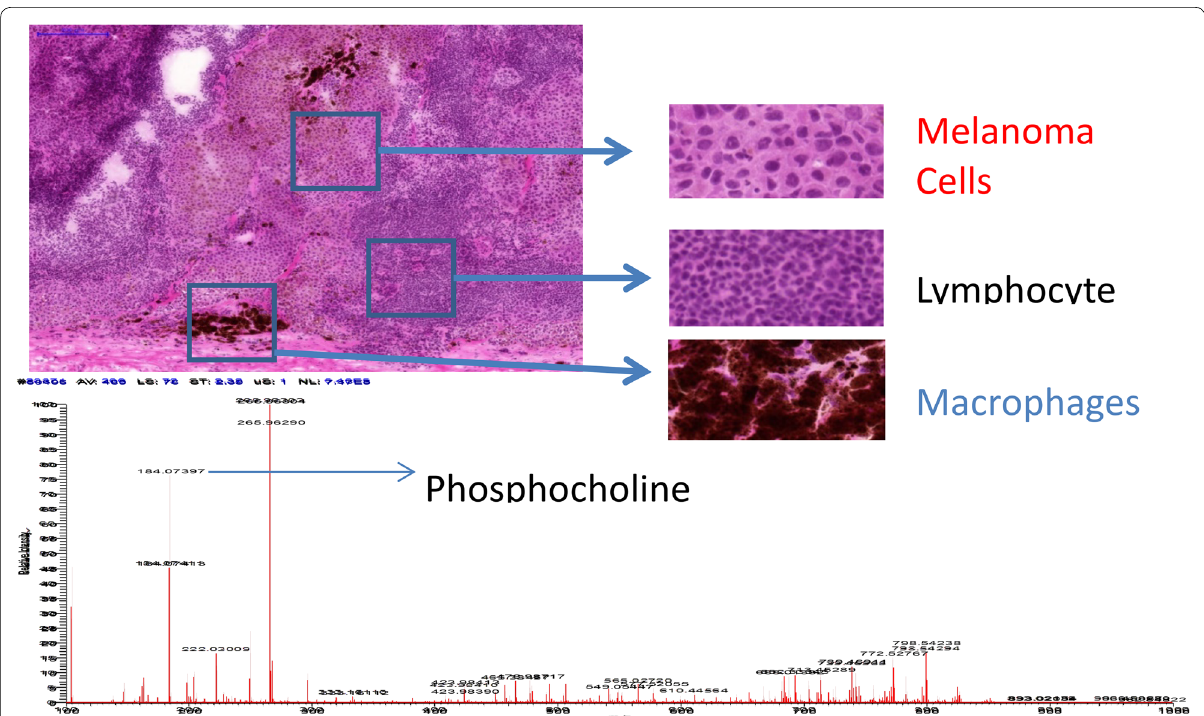
Fig. 5 Tissue compartment presentation in a melanoma tissue sample—different cell types dominate in different parts of the section. The corresponding mass spectrum is also given (lower panel). The coverage over the tumour was shown to vary substantially. Entire coverage was apparent for metabolites with m/z values of 184.073 and 222.030; whilst the metabolite at m/ z 296 only showed expression in the upper epithelial part of the tumour (data not shown). Phosphocholine is used as a